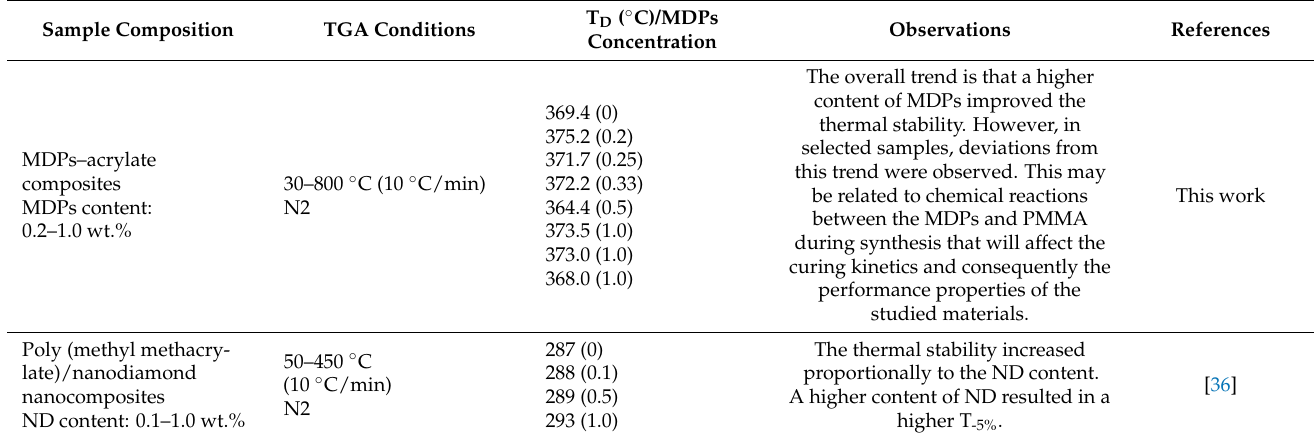
Table 3. Comparison of TGA for polymer/diamonds